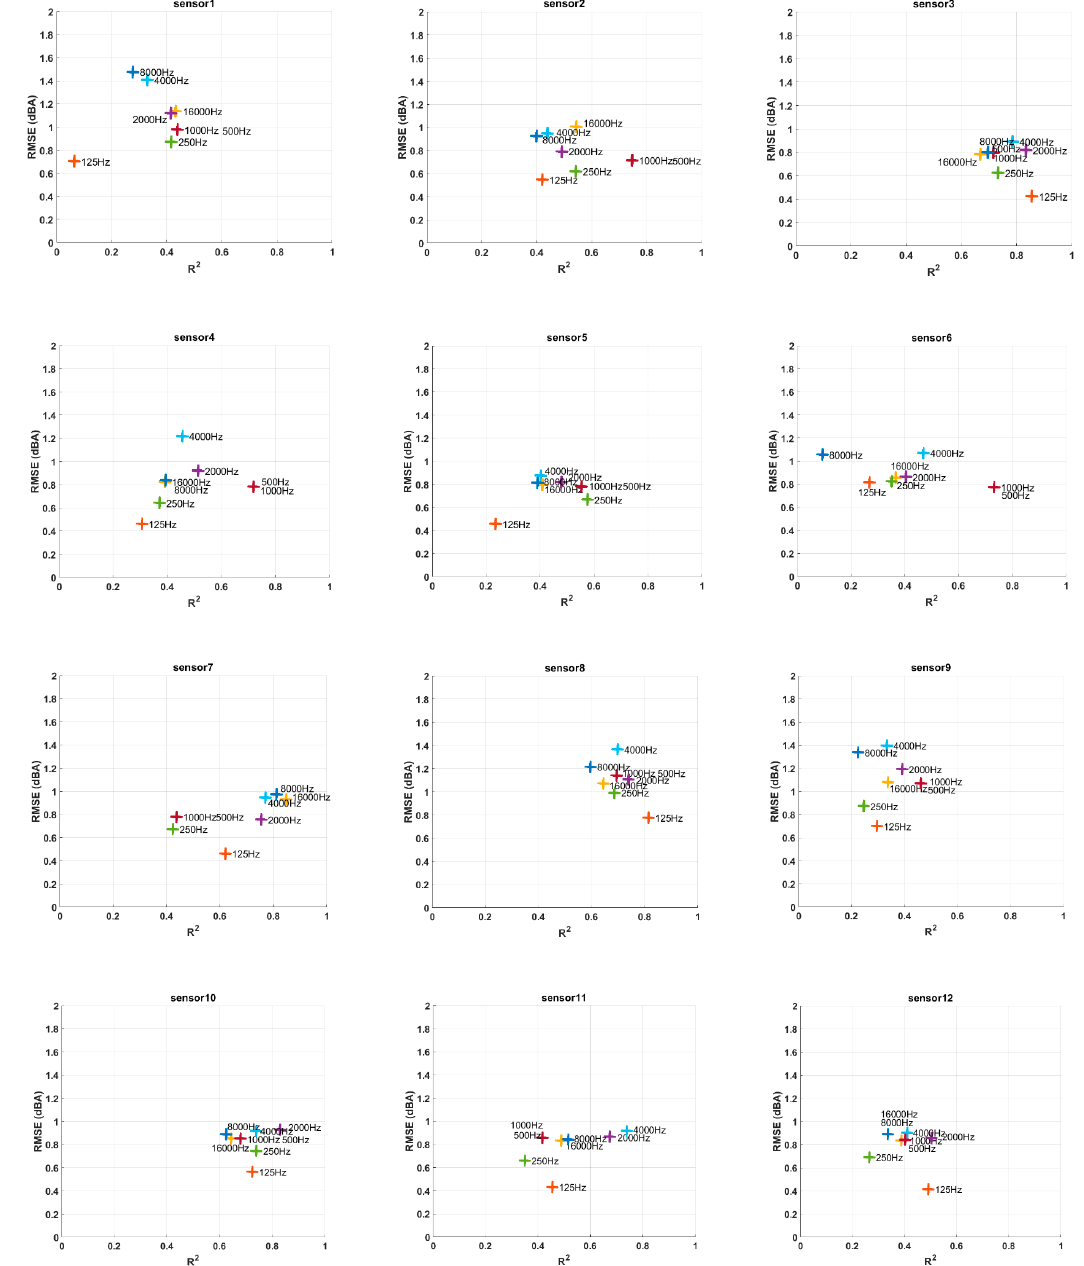
Figure 16. Different sensor prediction effects at different frequencies. Figure 16. Di ff erent sensor prediction e ff ects at di ff erent